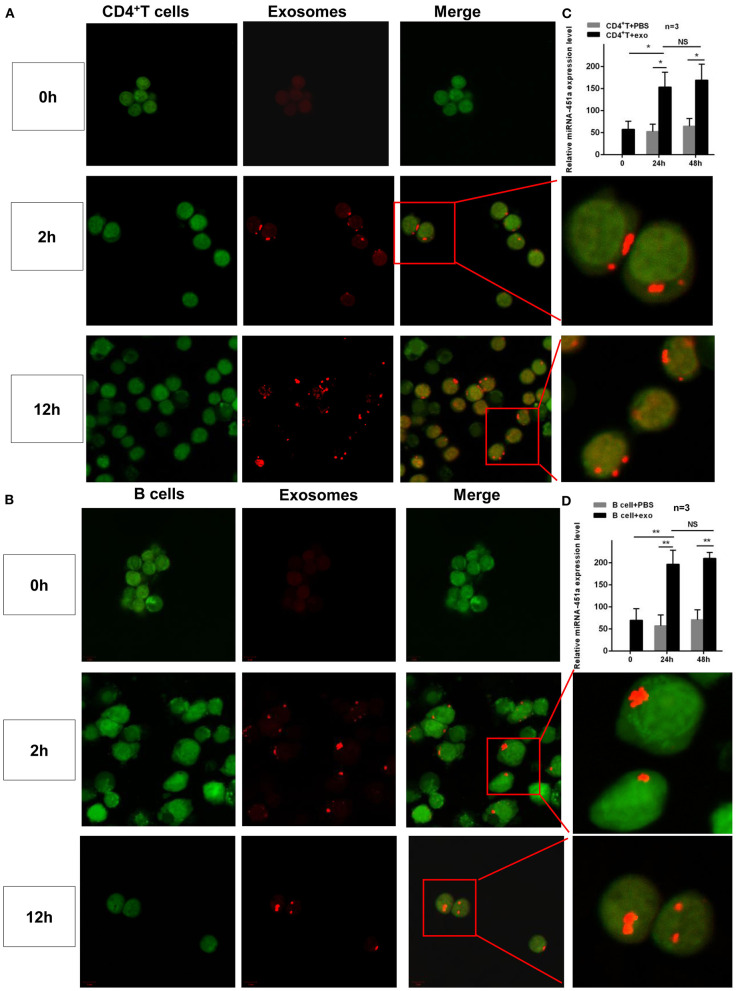
Dynamic observation of the effect of serum exosomes and target cells. Exo-Glow™-labeled exosomal RNAs were captured by (A) CD4+ T cells or (B) B cells entering the cytoplasm when cultured for 2 h in vitro and entering the nucleus when cultured for 12 h in vitro, as revealed by confocal laser microscopy. (C) Compared with that in CD4+ T cells before co-culture, the expression level of miR-451a in CD4+ T cells was significantly increased 24 h after co-culture of exosomes and CD4+ T cells, while it showed no difference at 24 and 48 h (n = 3). (D) The expression of miR-451a in B cells in an in vitro co-culture experiment showed the same trend (n = 3). *P < 0.05, **P < 0.01, NS, no significance.